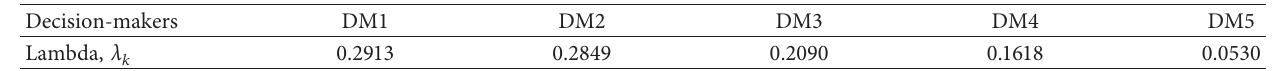
Table 5: Relative weights of decision-makers.